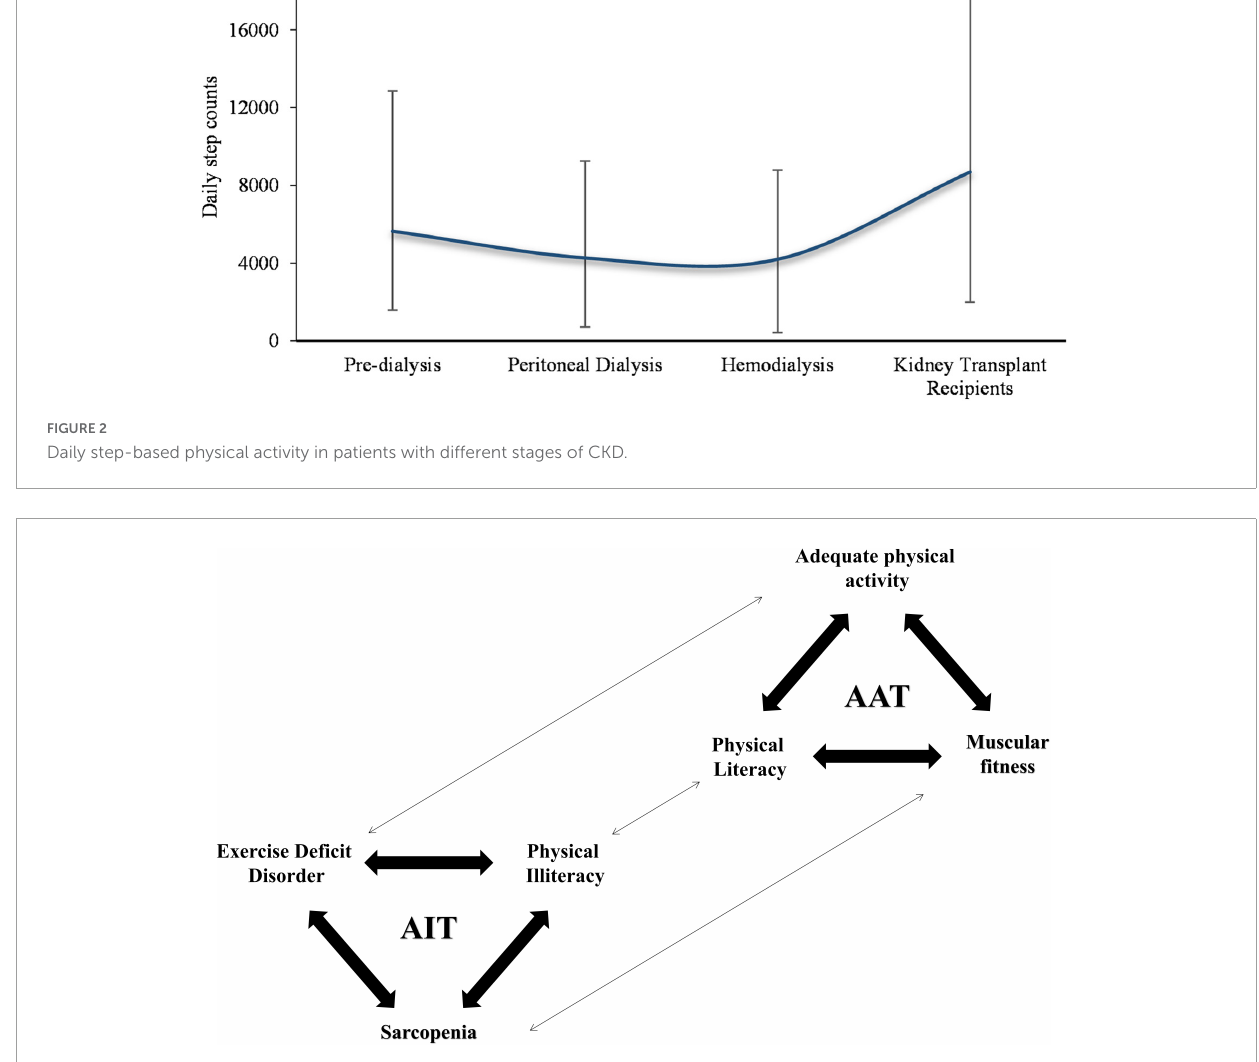
FIGURE3 The adult inactivity triad–adult activity triad continuum of physical activity in adult CKD patients. Adapted from Faigenbaum et al.